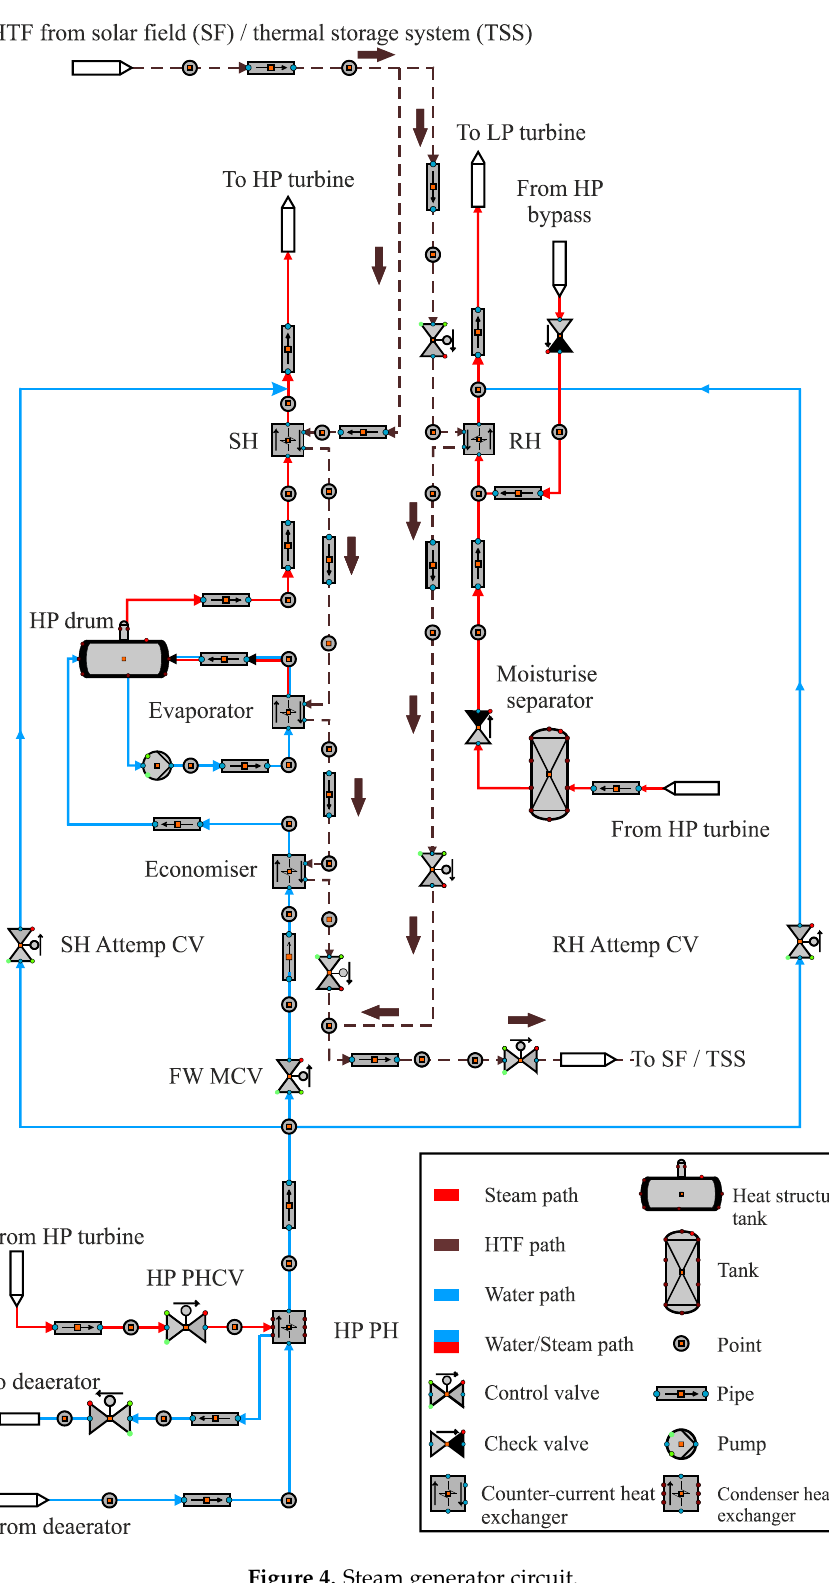
Figure 4. Steam generator circuit.